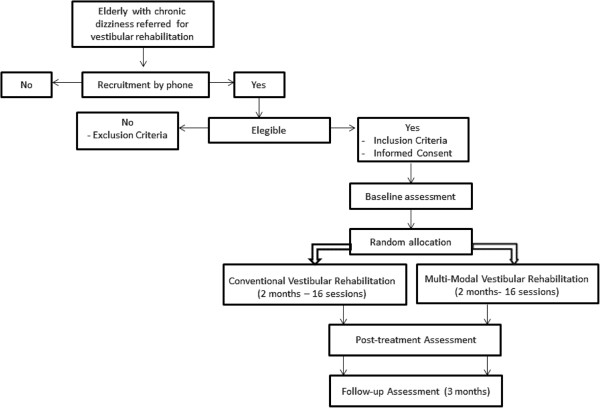
Trial flowchart.